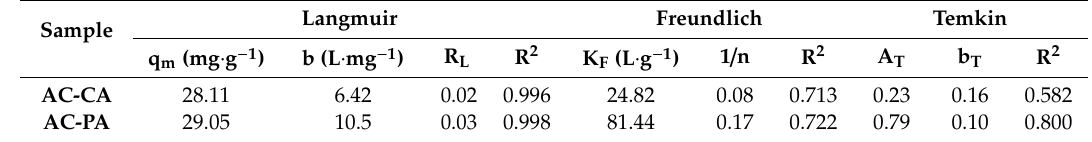
Table 2. Calculated isotherm parameters for the Langmuir, Freundlich, and Temkin linear models. Langmuir Freundlich Sample